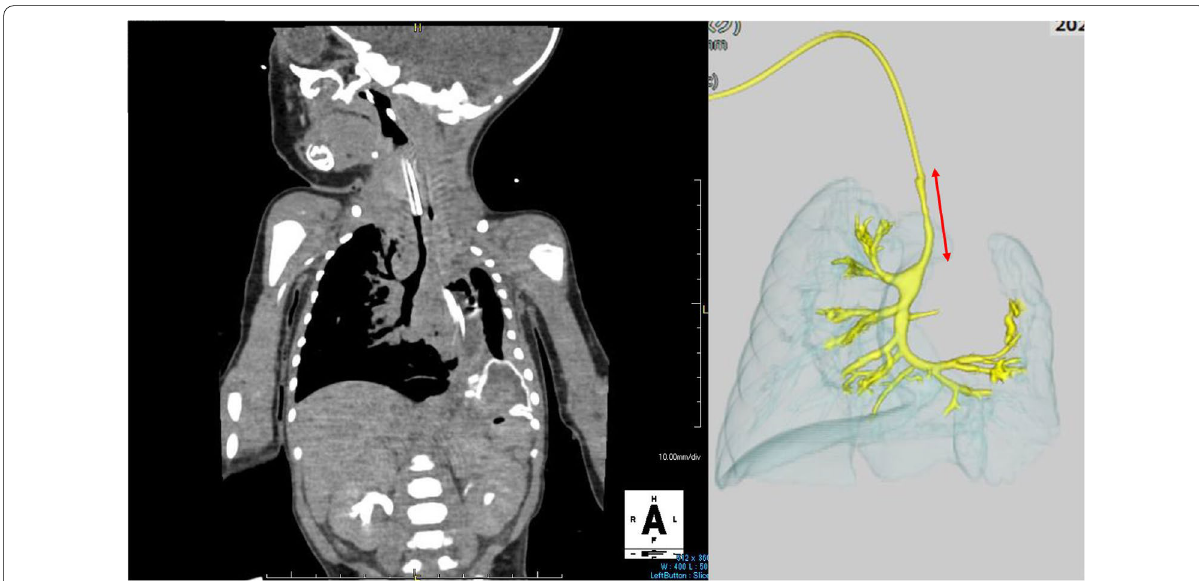
Fig. 2 Enhanced CT confirmed the diagnosis of CTS (arrow), and left lung agenesis. The tracheal stenosis was approximately 4 cm in length, extending from upper trachea to the just above right upper lobe